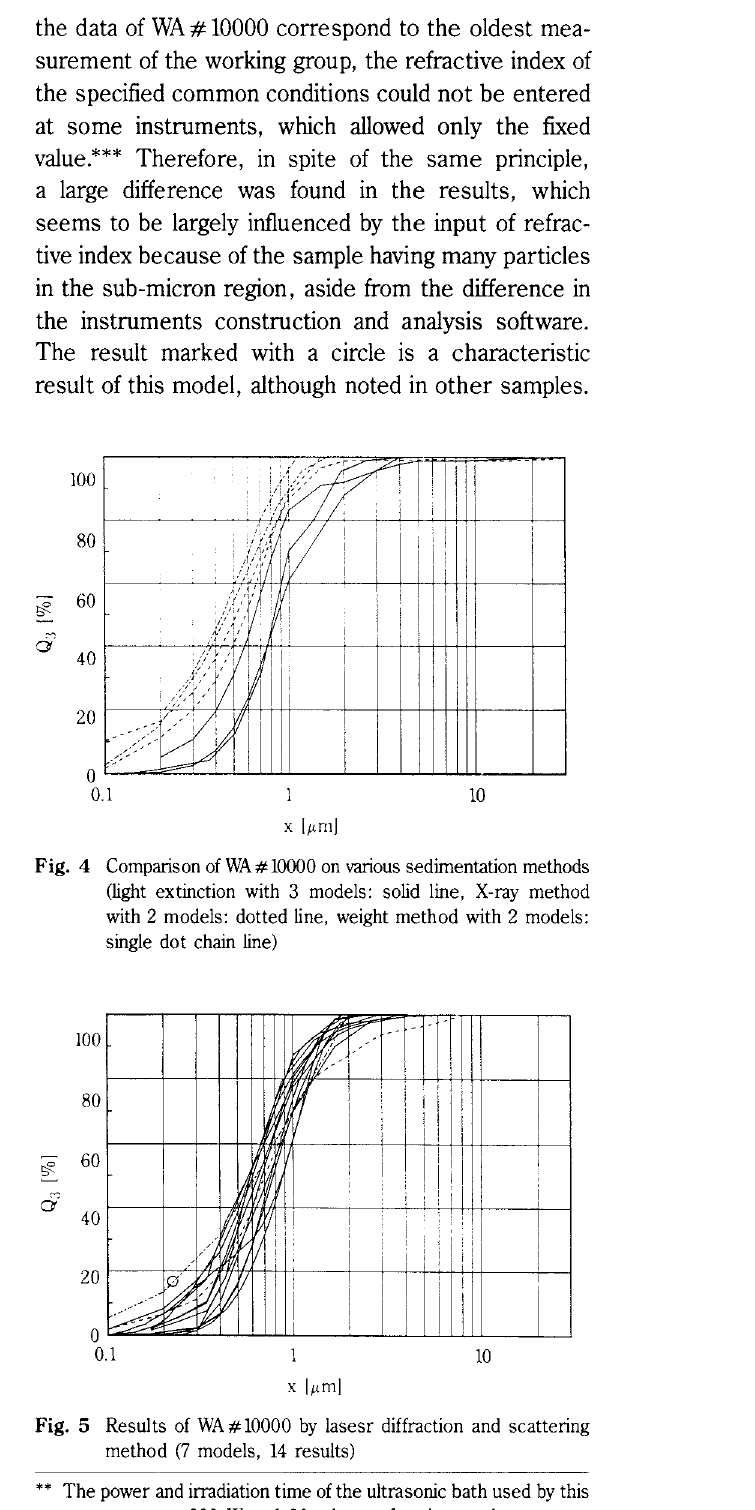
Fig. 5 Results of WA # 10000 by lasesr diffraction and scattering method (7 models, 14